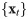
Prediction of single unit responses.(A) Top row: Example of an ACC unit (darker-gray curves) captured very well by the estimated PLRNN despite considerable trial to trial fluctuations (3 consecutive trials shown). Both model estimates from the directly inferred states (black curves) and from 1-step-ahead predictions of states zt (dashed curves) are shown. Bottom row: Example of another ACC unit on the same three trials where only the average trend was captured by the PLRNN when firing rates were estimated from either the directly inferred or predicted states. Gray vertical bars in all panels indicate times of cue/ response. State estimation in this case was performed by inverting only the single constraint corresponding to the largest deviation on each iteration (see Methods). (B) Correlations among actual ({xt}) and predicted ({x⌢t}) observations for all 19 neurons within this data set.